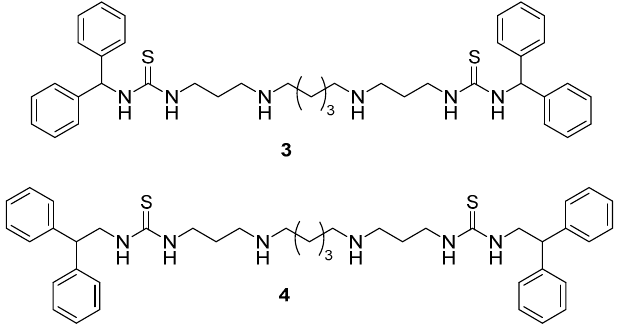
Figure 2. Structures of bis(thioureido) polyamines 3 and 4 .